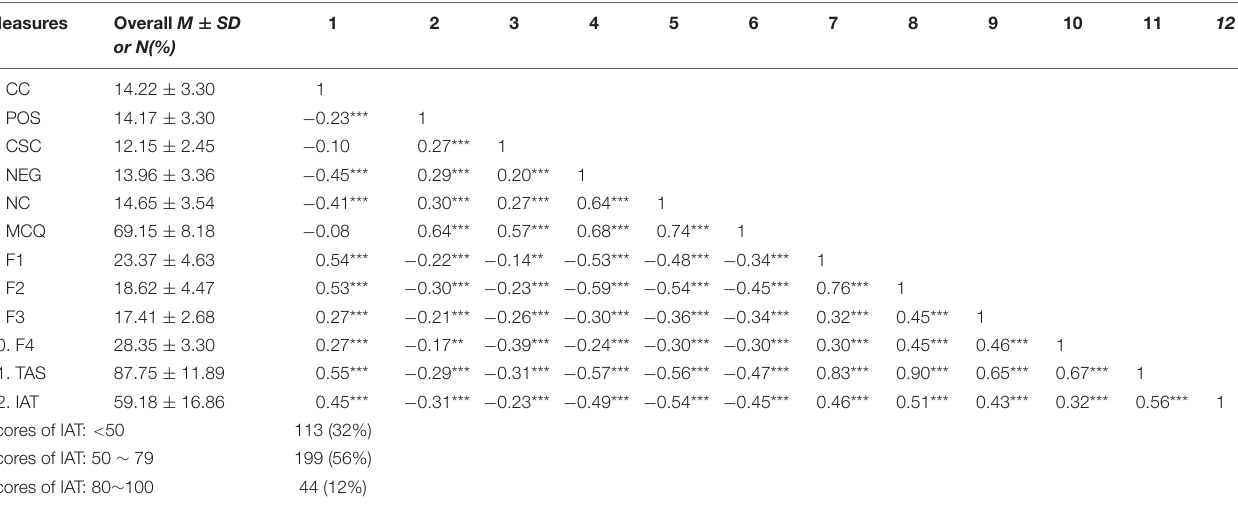
TABLE 1 | Descriptive statistics and partial correlations between alexithymia, Internet addiction, and metacognition with its dimensions. Measures